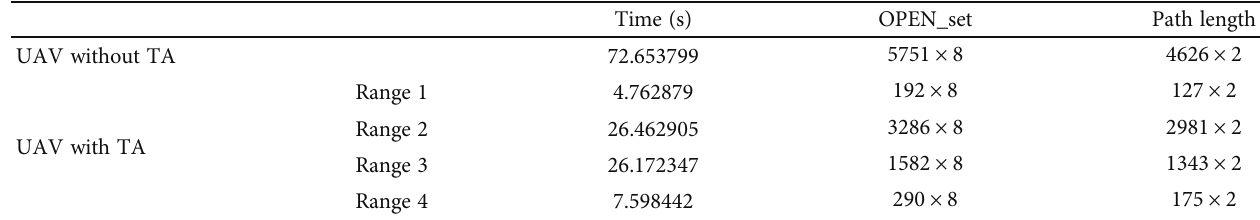
Time (s) OPEN_set Path length